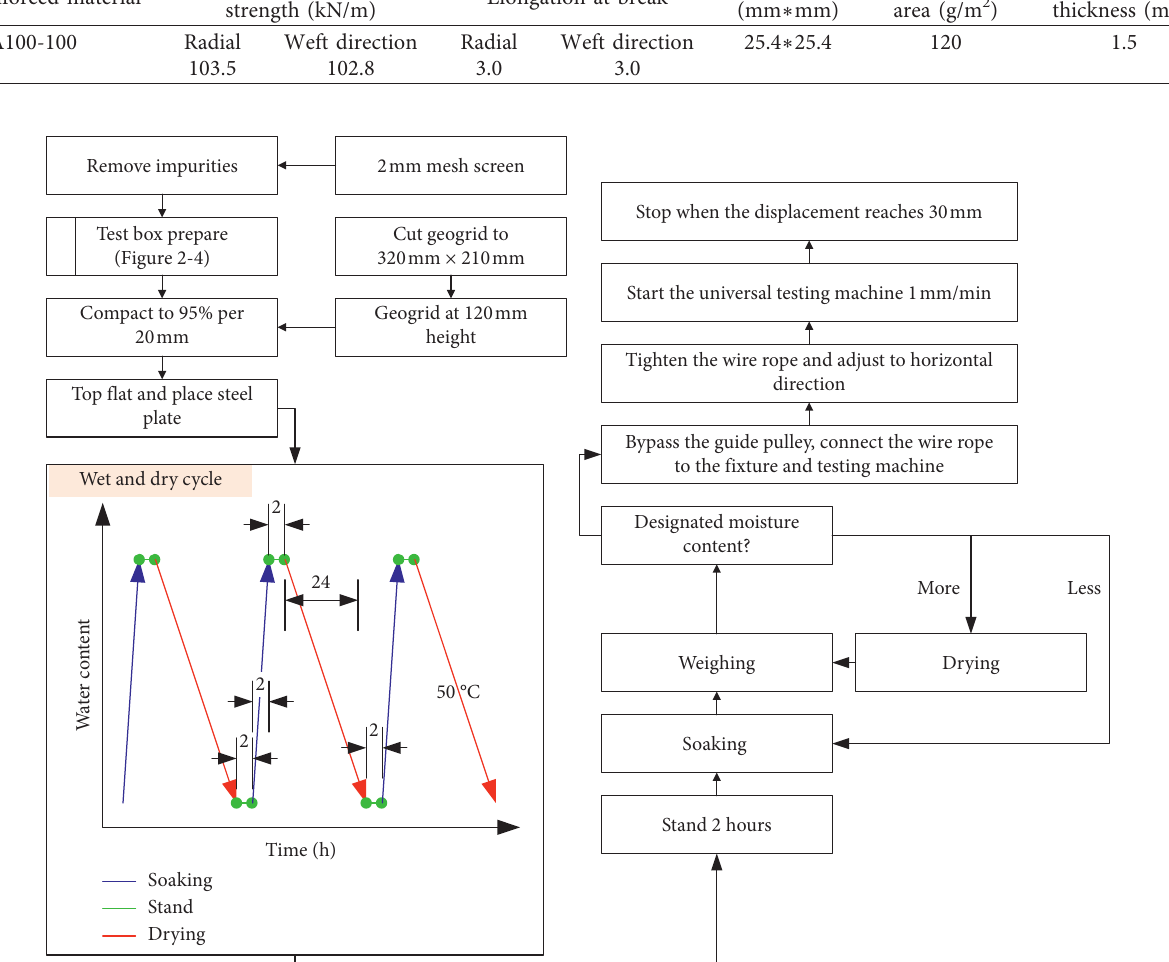
Figure 5: The experimental